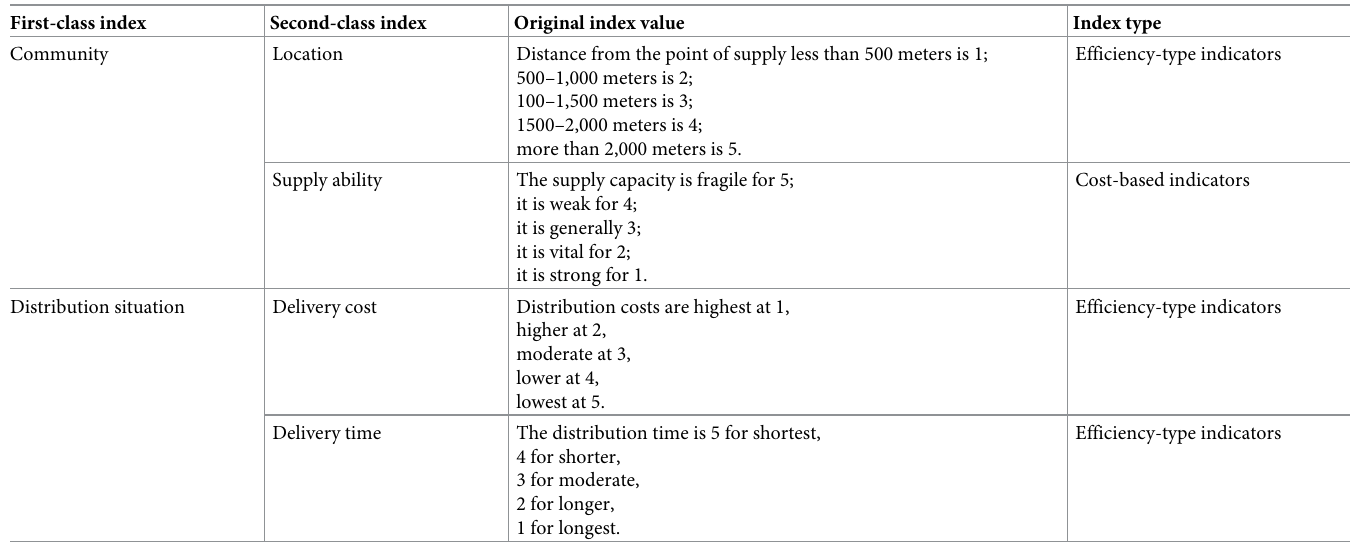
Table 3. The provider metric